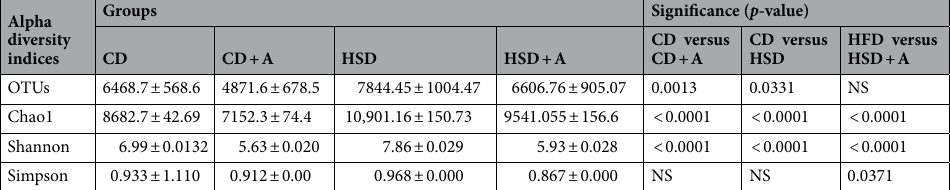
Table 3. Short term effect of high-salt (4% in chow) diet followed by Amoxicillin treatment on alpha diversity. Values are expressed as the means ± SD. Data were analyzed by one-way ANOVA, followed by Bonferroni test, n = 6, p ≤ 0.05, NS = Not significant, CD: Standard—chow diet for 3 weeks; CD + A.: Standard—chow diet for 3 weeks and underwent Amoxicillin treatment in 3rd week; HSD: High-salt diet for 3 weeks; HFD + A.: High- salt diet for 3 weeks and underwent Amoxicillin treatment in 3rd